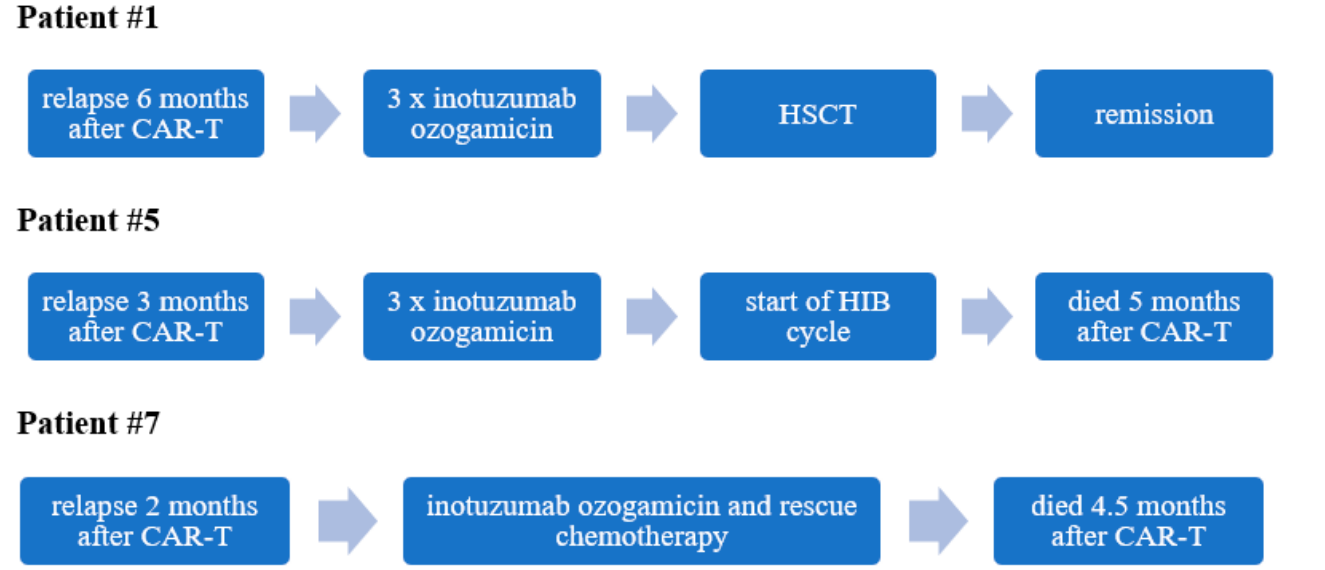
Figure 1. Clinical outcomes in relapsed patients; abbreviations: CHTX—chemotherapy; HIB— chemotherapy cycle according to IntReALL 2010 Protocol; TBI—total body irradiation, HSCT— hematopoietic stem-cell transplantation, CHTX—chemotherapy.